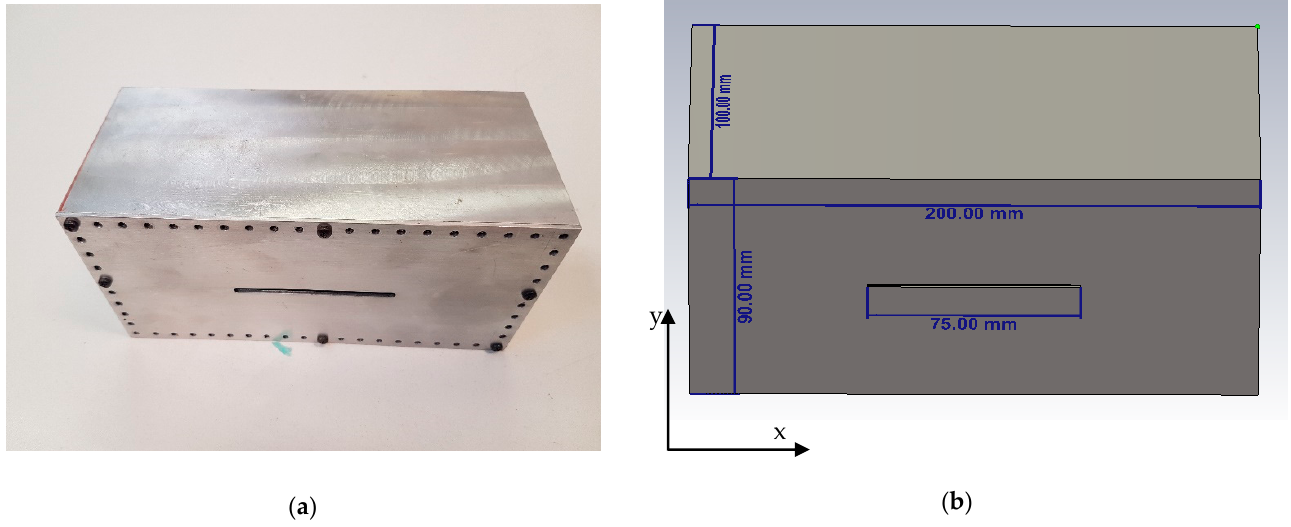
Figure 4. The EUT: ( a ) The real device, used for emission measurements in the reverberation chamber and in the anechoic environment; ( b ) The numerical model, used for full wave simulations.